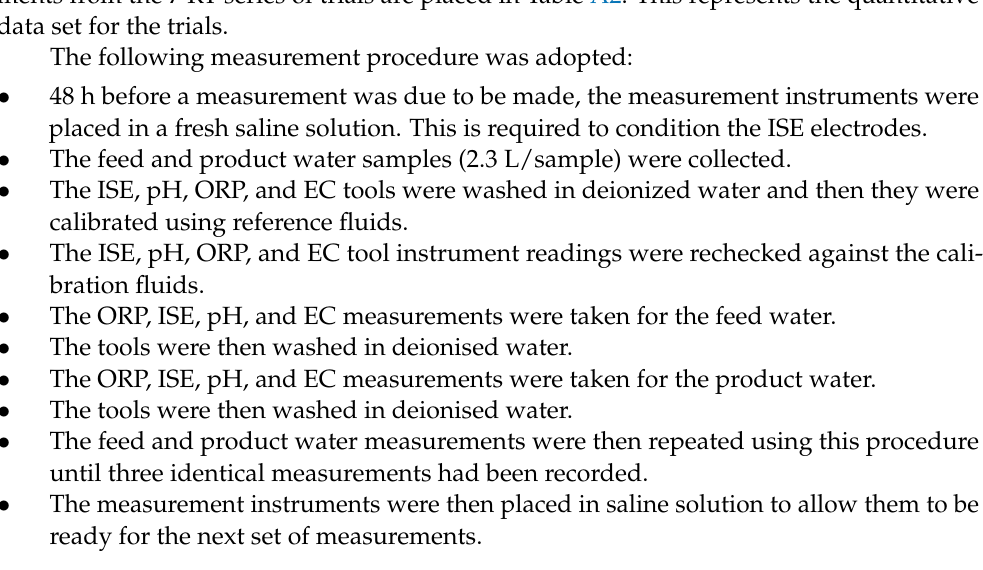
Table A1. ZVI desalination: replication results. F w = feed water; P w = product water. Trials 63 to 66 and 67 to 69 are replications, where the feed water composition for each trial was